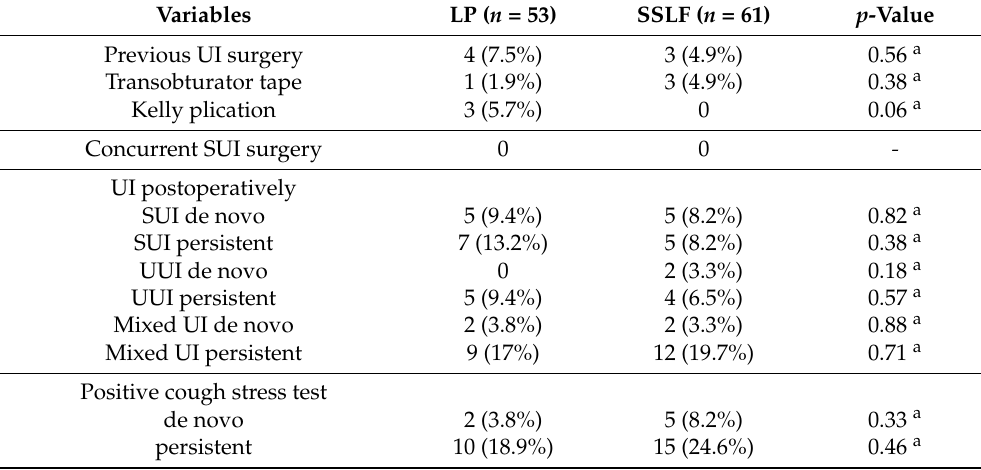
Table 2. Urinary incontinence